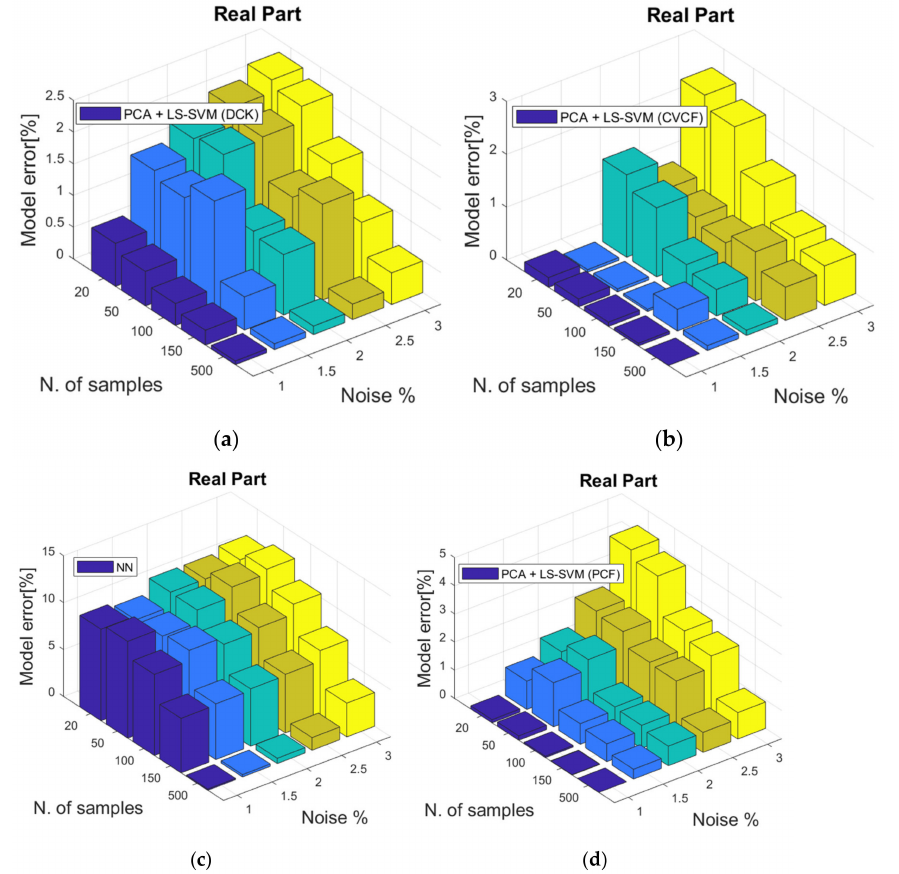
Figure 8. Three-dimensional plot of the relative NRMSE computed on the real part of the test samples at a single frequency point selected as the one providing the maximum error via the proposed approaches (see panel ( a ) for the DCK, panel ( b ) for CVCF and panel ( d ) for PCF), and a multi-output feedforward NN (see panel ( c ))for different values of the noise standard deviation σ n and the number of training samples